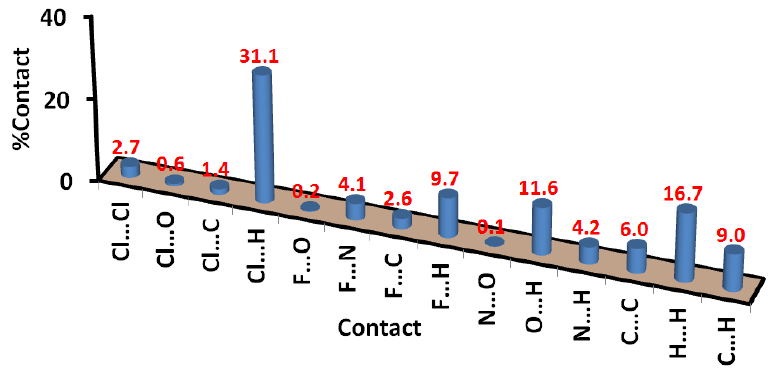
Figure 9. Intermolecular contacts and their percentages in Pd(II) complex 4 .